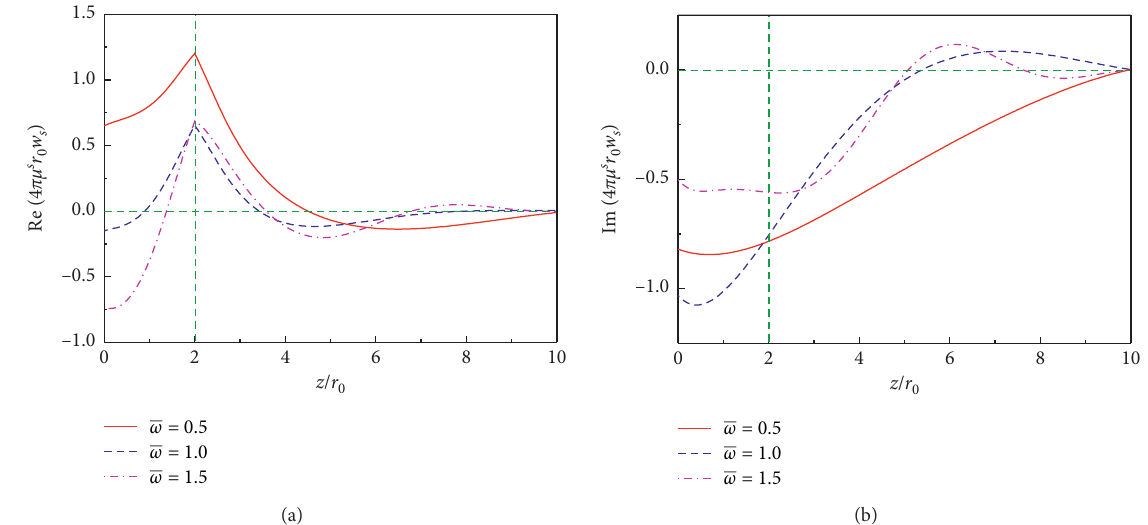
Figure 4: Vertical displacement w